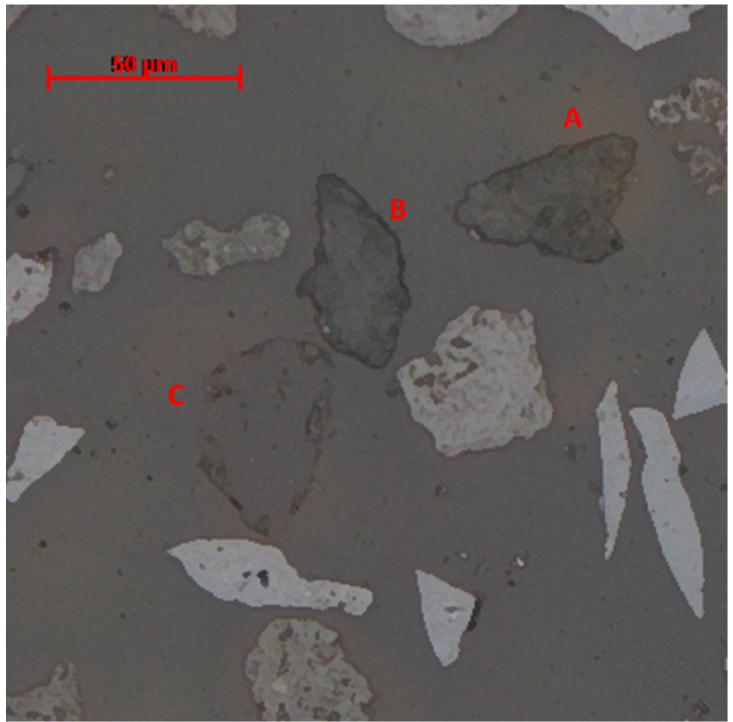
Figure 2. Non ‐ opaque particles at magnification ×200 with different border and body visibility: high × 200 with different border and body visibility: high (A, B) and low (C). Figure 2. Non-opaque particles at magnification (A, B) and low (C).